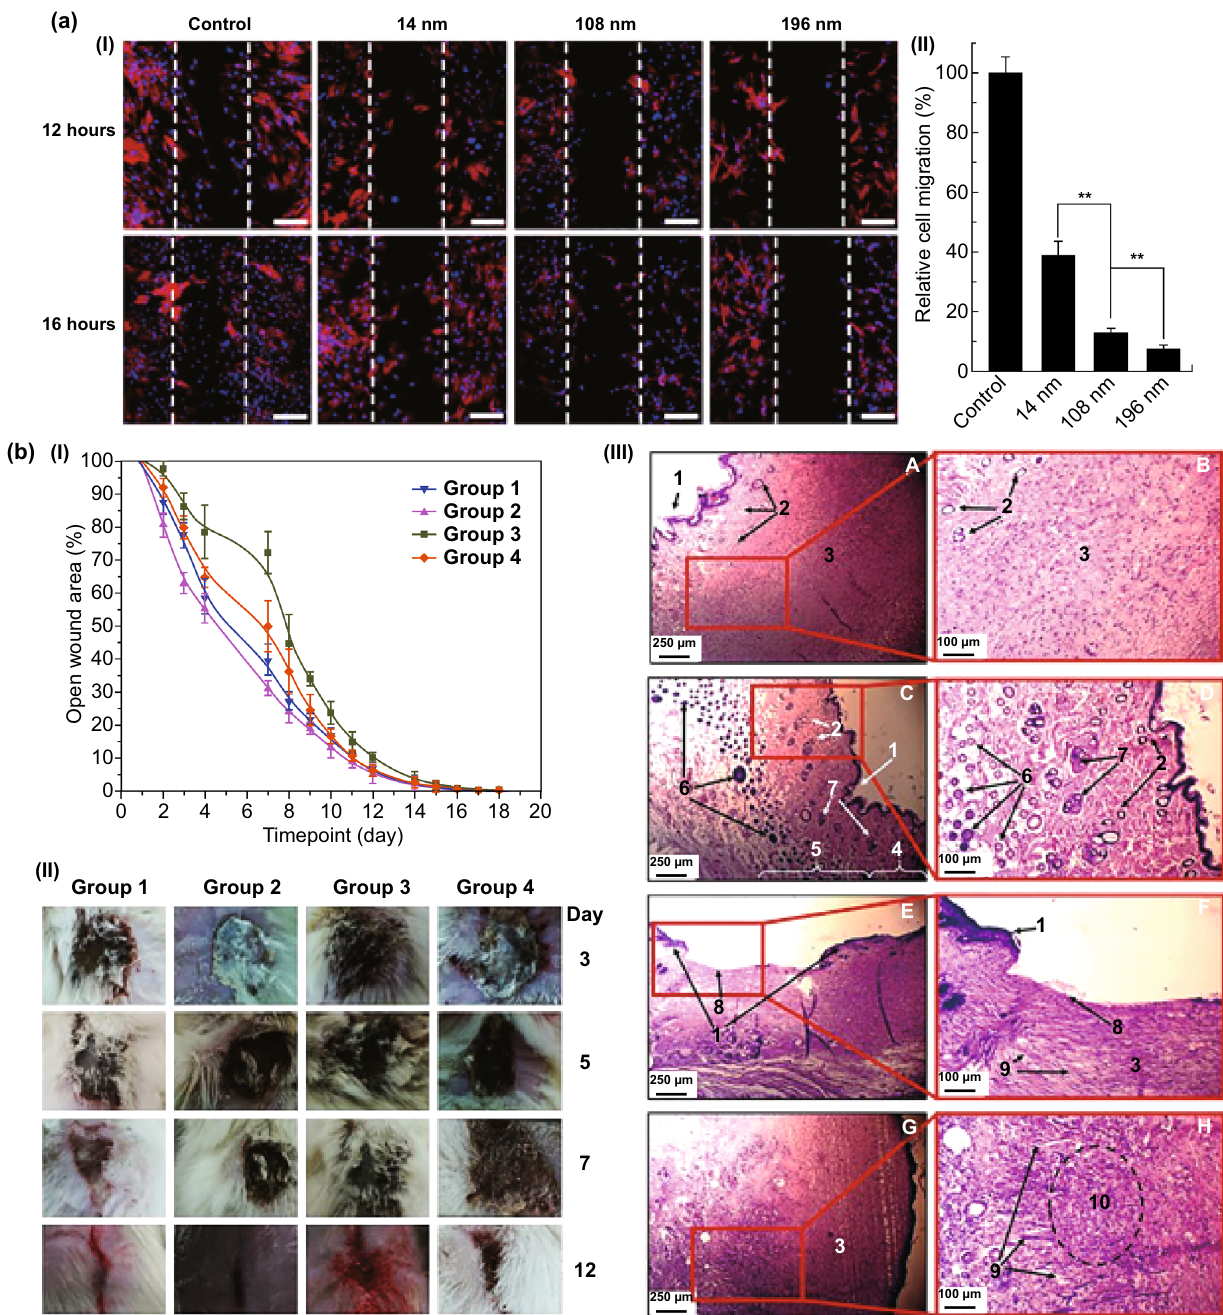
Fig. 10 a Cellular migration of mesenchymal stem cells incubated with different sized TiO 2 particles. Scale bars show 100 μm. Adapted from Ref. [208] with permission from the Dove Press Ltd. b The wound‑healing process (I) macroscopically analyzed over the course of 19 days, (II) the representative wounds through the healing process for each group, and (III) the optical images of the healed skin from group 1 (A and B), group 2 (C and D), group 3 (E and F), and group 4 (G and H). Numbers indicate tissue structural elements: 1—epidermis; 2—sweat glands; 3— scar; 4—derma; 5—hypodermis; 6—hair follicles; 7—sebaceous glands; 8—de‑epithelialized scar tissue; 9—scar vessels; 10—inflammatory infiltration in the scar. Adapted from Ref. [214] with permission from the Springer